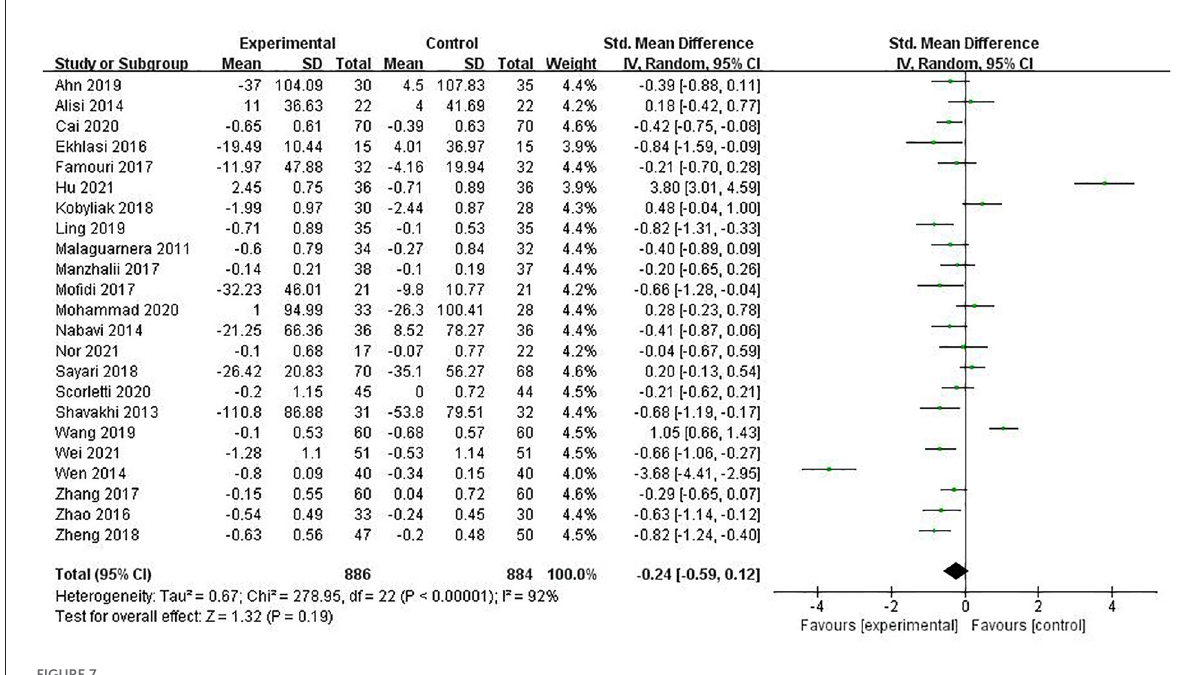
FIGURE7 The role of PPS in TG in patients with NAFLD.